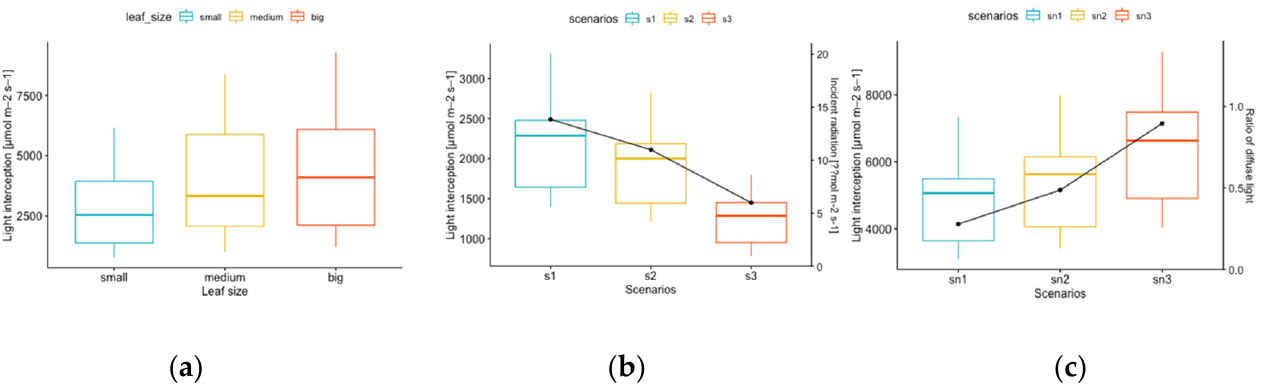
Figure 5. ( a ) Boxplot of light interception (µmol s − 1 ) per plant among groups with different leaf sizes (small, medium, big); ( b ) boxplot of light interception (µmol s − 1 ) per plant under different light conditions, with the line indicating the incident radiation (µmol m − 2 s − 1 ); ( c ) boxplot of normalized light interception (µmol s − 1 ) per plant under different light conditions, with the line indicating the ratio of diffuse light (compared to total incident radiation), ranged from 0–1. Scenarios include s1 (27.8% of diffuse light, 426.41 µmol/m 2 s of incident PAR), s2 (48.7%of diffuse light, 336.16 µmol/m 2 s of incident PAR), and s3 (89.6%of diffuse light, 183.18 µmol/m 2 s of incident PAR); the scenarios of normalized incident radiation (sn1, sn2, and sn3) have the same ratios of diffuse light as s1, s2, and s3, respectively.